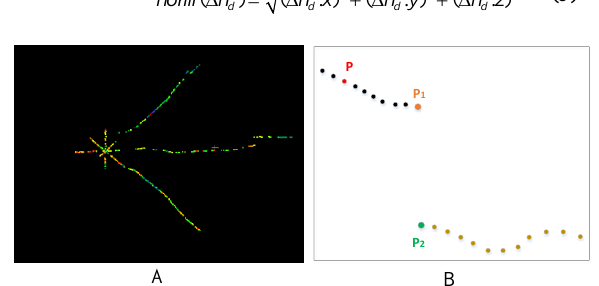
Figure 2. Illustration of “directional height above” feature in 8 directions